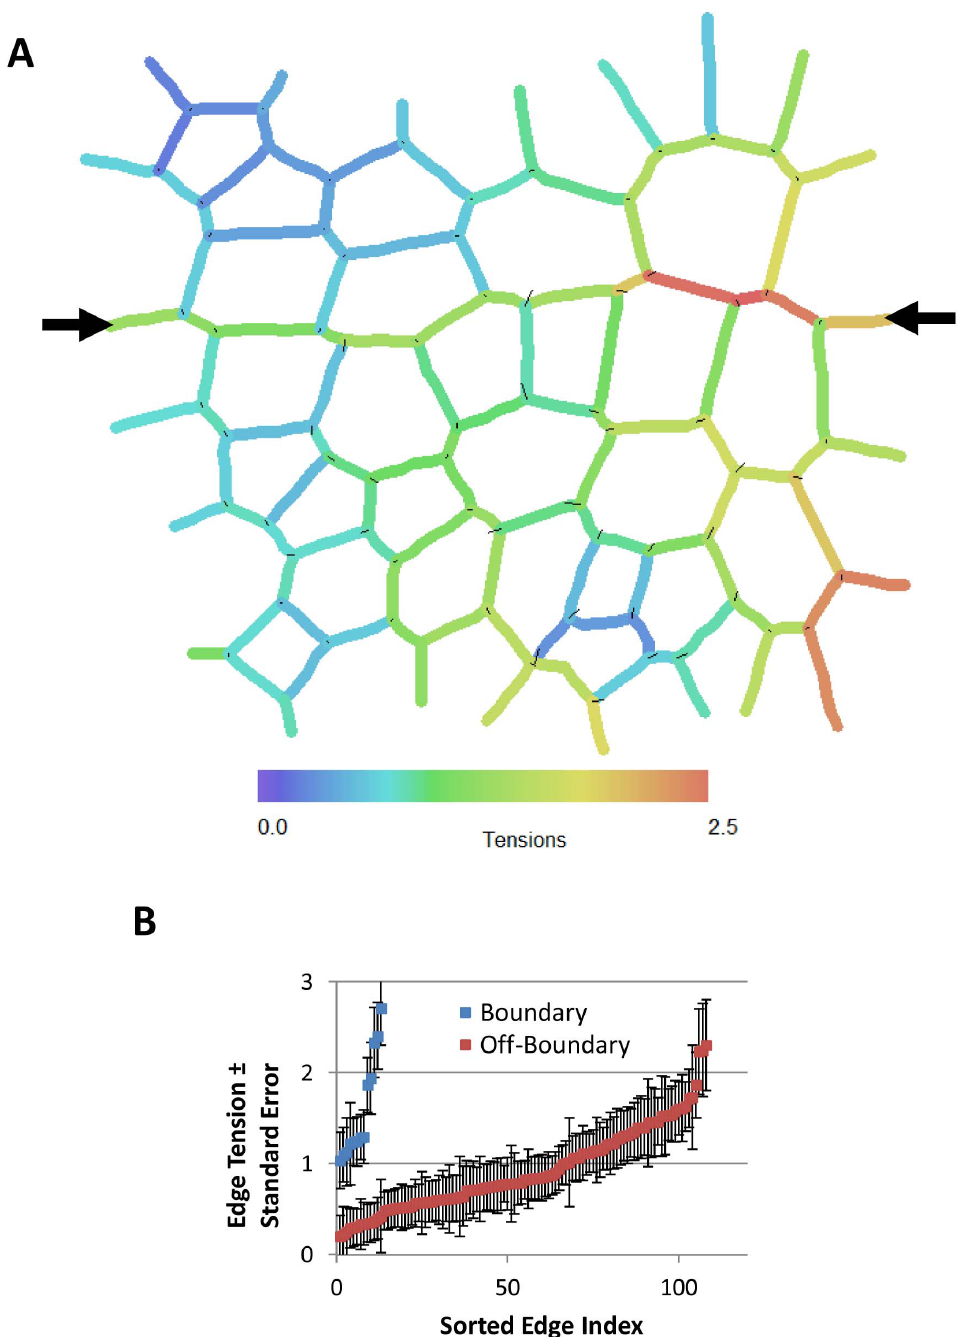
Figure 6. CellFIT analysis of a wing imaginal disc from a living Drosophila larva. ( A ) shows the inferred Standard Tensions based on Fig. 4D of Reference [4]. The tension equations are well conditioned (condition number of 11.1), the confidence limits are acceptable and the force residuals are a bit larger than for the previous case. The black arrows in ( A ) indicate the boundary between compartments within the imaginal disc. ( B ) shows that the forces along that boundary tend to be higher than those elsewhere (see also text). Pressures were not calculated as boundary curvatures could not be obtained from the source image.